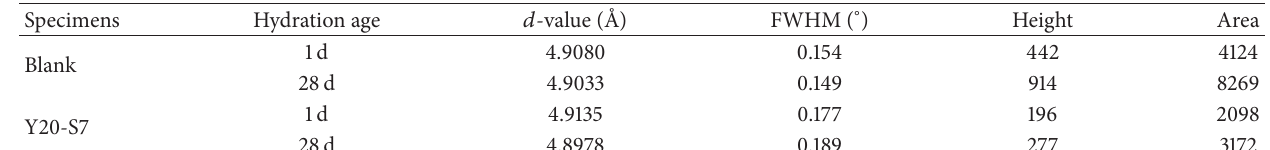
Table 5: The integrated results of XRD diffraction peak of CH corresponding at 2 𝜃 range of 17.0–19.0 ∘ .